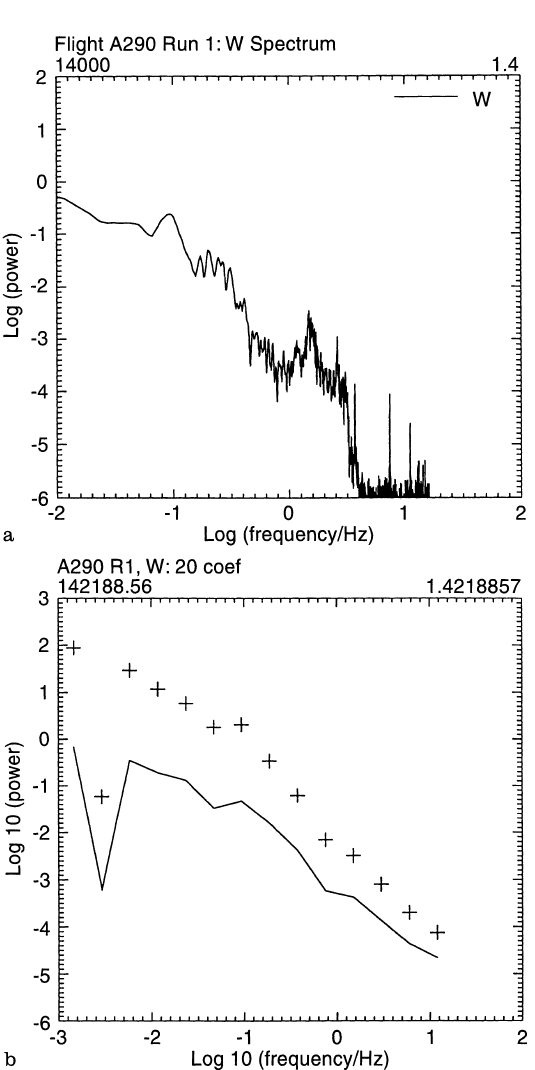
Fig. 7. a Fourier spectrum for the data shown in Fig. 3 (A283 run 1). The x -axis shows the base-10 logarithm of the frequency (Hz), and the y -axis shows the base-10 logarithm of the spectral density. The numbers at the top of the diagram give the scales at the plot limits. b As for a, but for the average wavelet spectrum. The crosses show the average energy at each scale plus the standard deviation of the energy over the time-series. Note that the axes are slightly di(cid:128)erent, with the x -axis extending down to ) 3 instead of just ) 2, and the y -axis up to 3 instead of 2